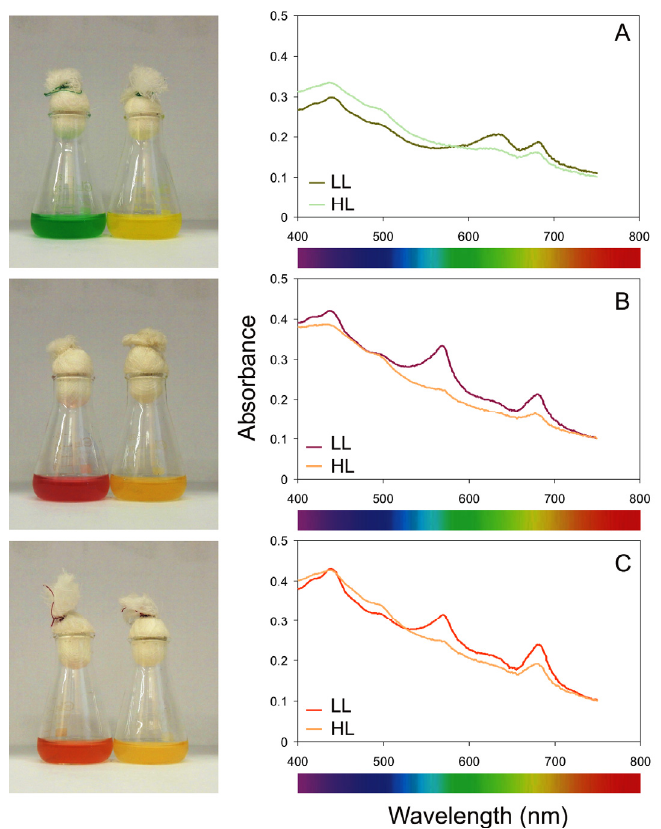
Figure 6. Left-side panel—photographs of the picocyanobacterial phenotypes in 100 mL glass Erlenmeyer flasks: Type 1 ( A ), Type 2 ( B ), and type 3a ( C ), obtained from low (left) and high (right) light; right-side panel—Absorbance spectra measured in the PAR range determined for the picocyanobacterial phenotypes at an optical density (OD 750 ) = 0.1, obtained from low light (LL) and high light (HL).